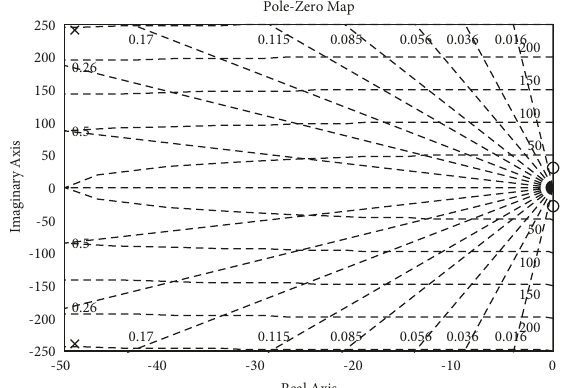
Figure 11: Zero-pole diagram of the controlled